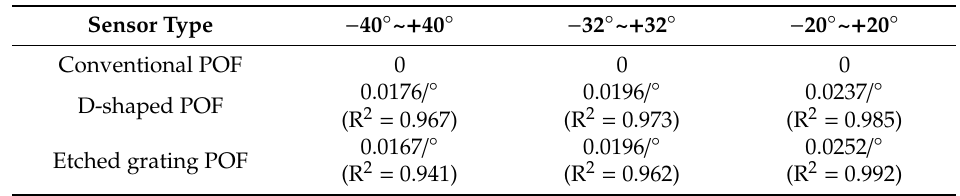
Table 1. The solved normalized angle sensitivity and corresponding goodness of fit at various angle